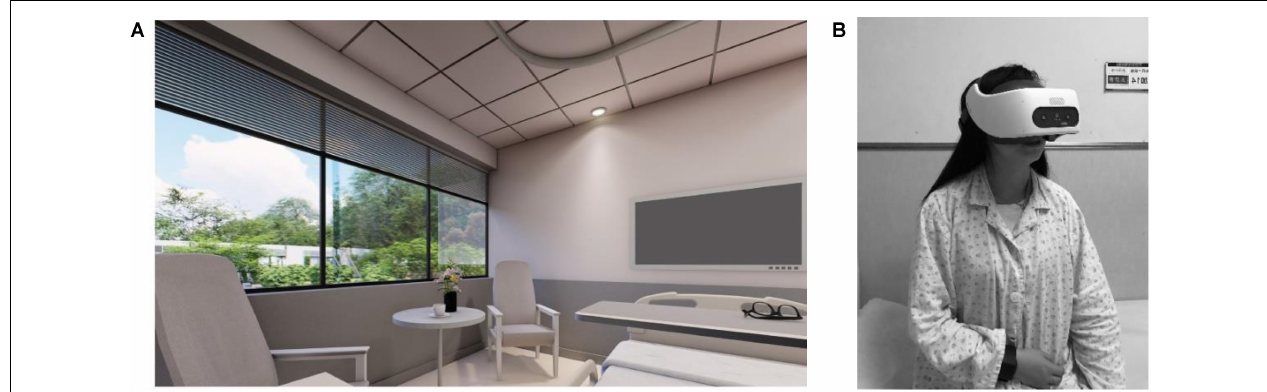
FIGURE 1 | Virtual reality (VR) device HTC Vive Focus Plus and presenting virtual scene. (A) Virtual scene of the ward. (B) Participant wearing